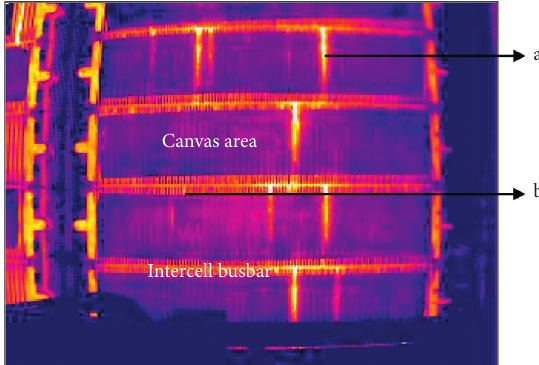
Figure 2: IR image of electrolytic cells taken at the top of cells surface: a is a common short circuit and b is a short circuit that has not caused the canvas temperature